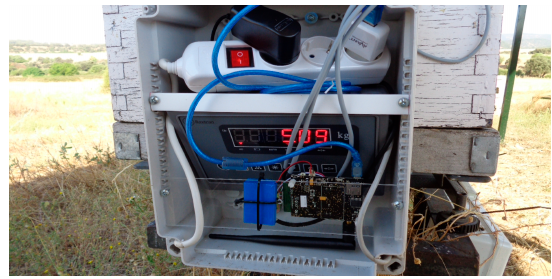
Figure 3. Photograph of one of the nodes installed in the beehive.